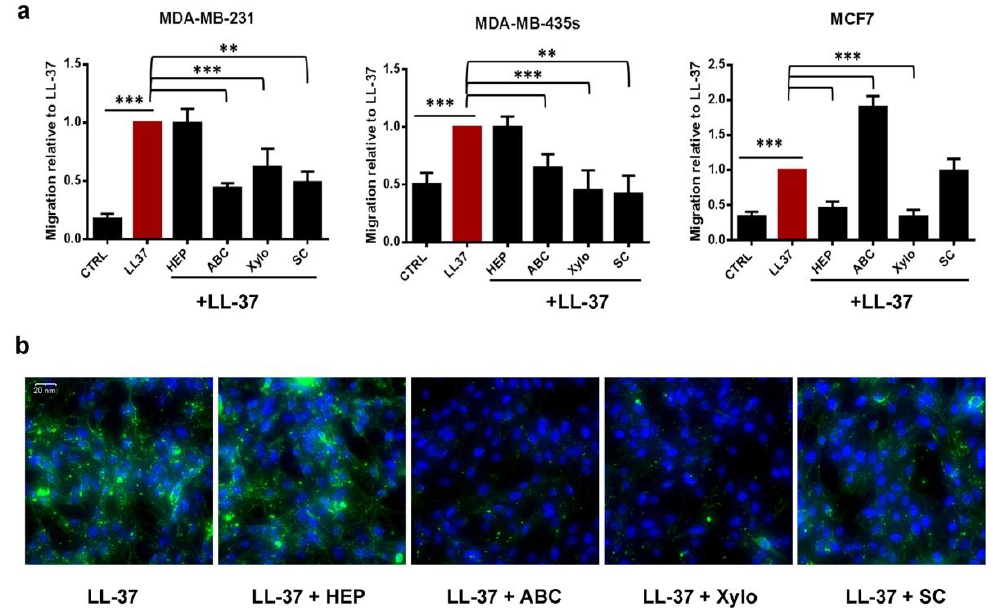
Figure 3. Digestion of membrane chondroitin sulfate and heparin and inhibition of glycoaminoglycan synthesis decrease membrane fixation of LL-37 and cell migration. ( a ) Migration of MDA-MB-231, MDA-MB-435s and MCF7 cell lines induced by LL-37. Cells were previously incubated or not with different enzymes digesting glycoaminoglycans (Hep: heparinases I/III, treatment 5mUI/mL 1 h, ABC: chondroitinase ABC, treatment 1 UI/mL 1 h, Xylo: 4-Methylumbelliferyl- β - D -xyloside 0.5 mM) or with an inhibitor of sulfatation (SC — sodium chlorate 30 mM) (N = 4). ( b ) Immunofluorescence labeling with anti-LL-37 on MDA-MB-231 cells previously treated or not as in (a). Magnification ×400. Data are normalized to LL-37. Statistics: *** p < 0.001, ** p < 0.01, * p < 0.05, relative to LL-37 and relative to control without LL-37, respectively.